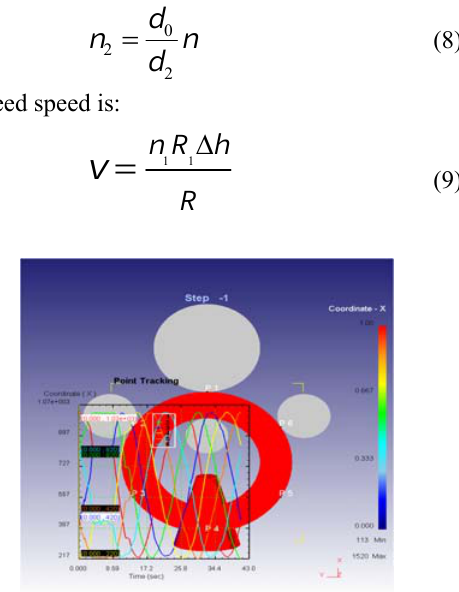
Fig. 5. The distributed points on the ring’s end face